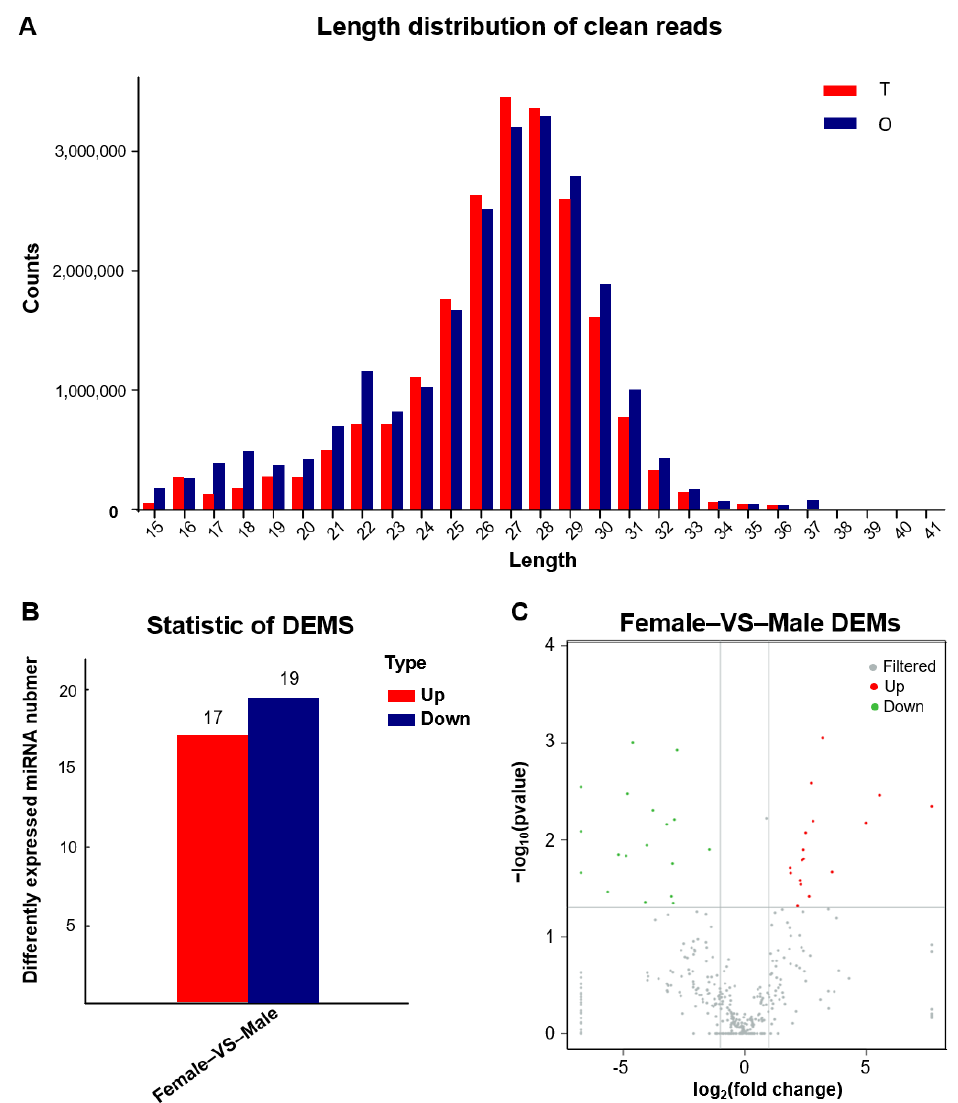
Figure 2. Identification of miRNAs. ( A ) Length distribution of clean reads from six libraries of the A. fasciatus . ( B ) Statistic of differently expressed miRNAs (DEMs) in gonads of A. fasciatus . ( C ) Volcanic map of differential miRNAs in female and male A. fasciatus gonads.